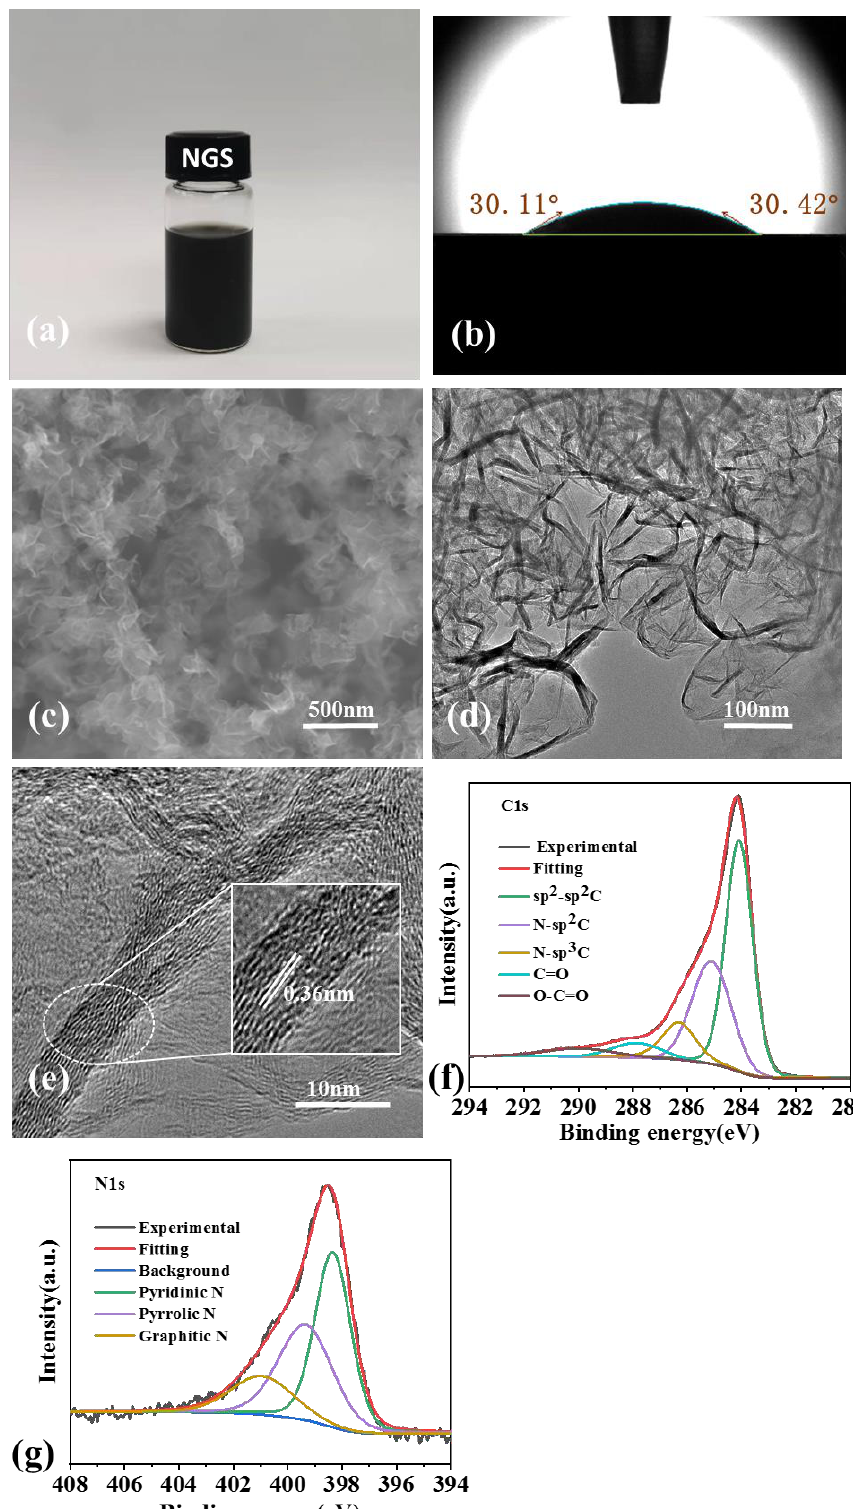
Figure 2. ( a ) Dispersion study of NGS in water (1 mg mL − 1 ), ( b ) contact angle of water for NGS; ( c ) SEM image ( d , e ) TEM images of NGS; ( f ) C1s; and ( g ) N1s XPS spectra of NGS.